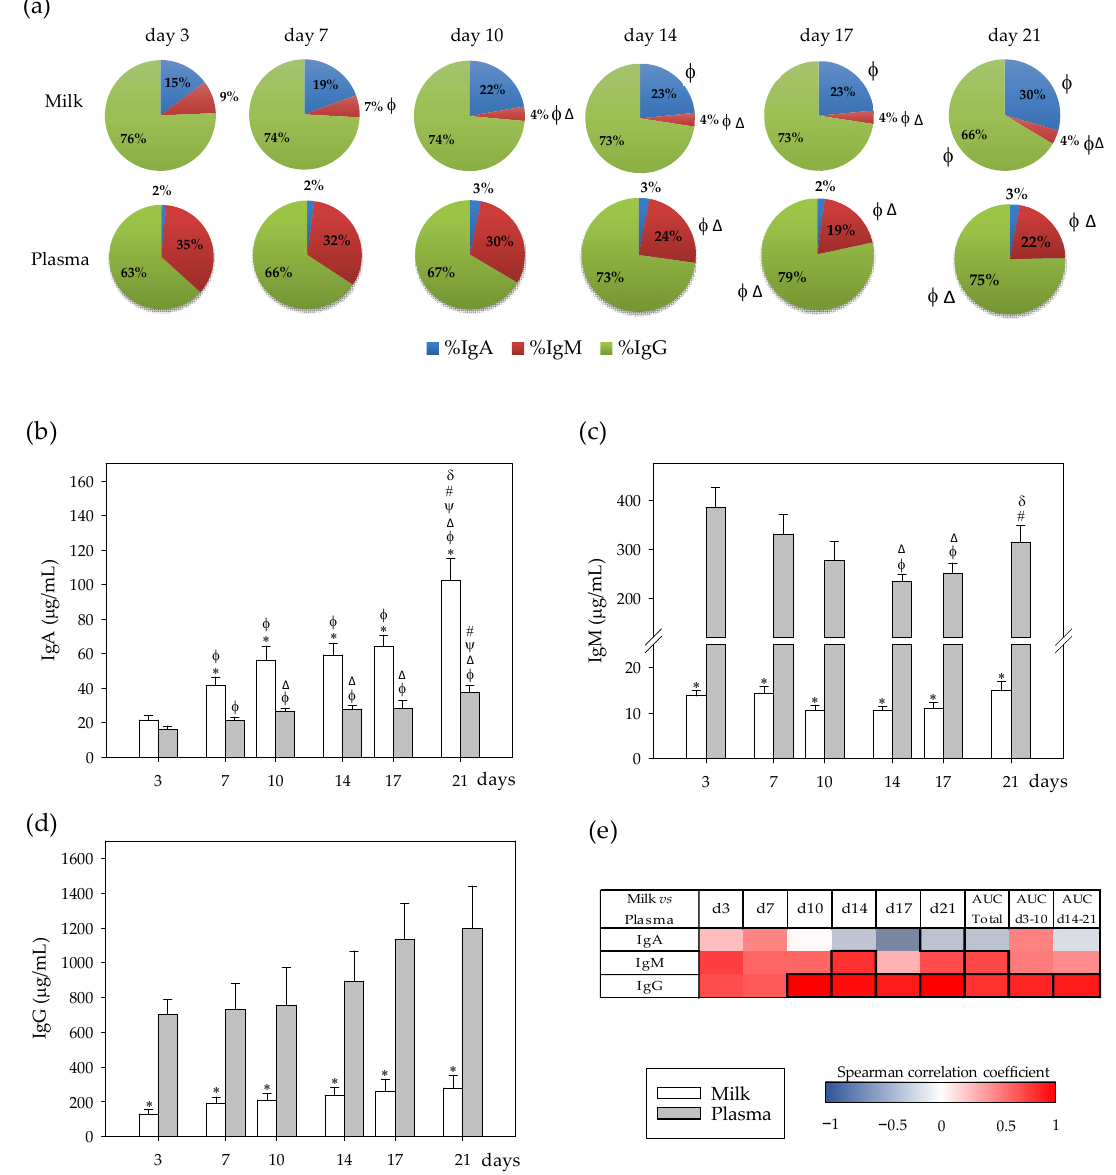
Figure 1. ( a ) Percentage of immunoglobulins (Ig) in milk and plasma from dams. ( b ) Milk and plasma concentration of IgA, ( c ) IgM, and ( d ) IgG throughout the lactation period. ( e ) Correlations between milk and plasma Ig levels at specific days: 3 (d3), 7 (d7), 10 (d10), 14 (d14), 17 (d17), and 21 (d21), while also considering their area under the curve during the whole lactation period (AUC total ), and AUC on the first (AUC d3–10 ) and the second period (AUC d14–21 ) of the study. The Spearman correlation coefficient is represented in the heat map following the color in the legend. Correlations with statistical significance ( p < 0.05) are shown in a bold frame. Statistical differences: * p < 0.05 vs. plasma on the same day; φ p < 0.05 vs. day 3, ∆ p < 0.05 vs. day 7, ψ p < 0.05 vs. day 10, # p < 0.05 vs. day 14, and δ p < 0.05 vs. day 17 for the same type of sample ( N = 6–8).